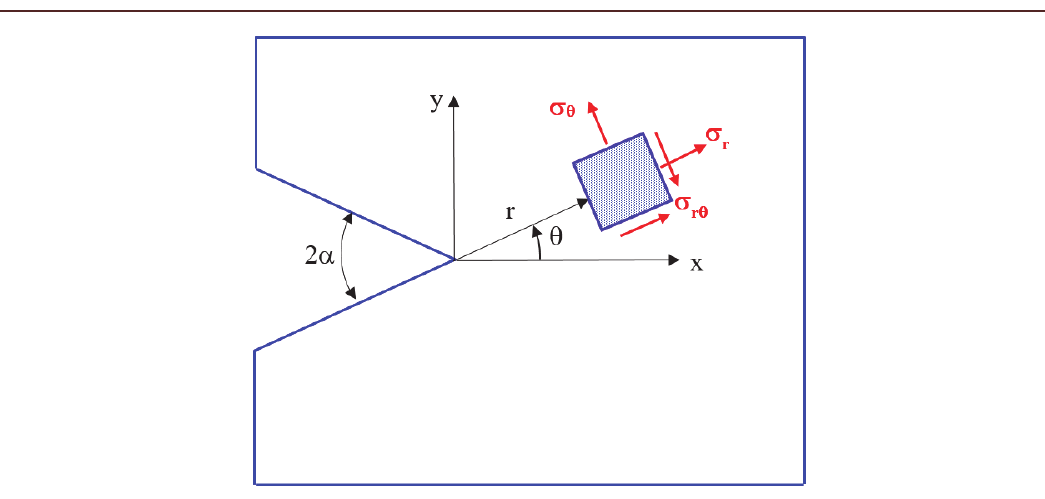
Figure 2: Polar coordinate system for V-shaped notches, with z normal to the plane; Mode I NSIF linked to the stress component   evaluated along the notch bisector line (  =0); under mode III the shear stress component  z  is oriented as  